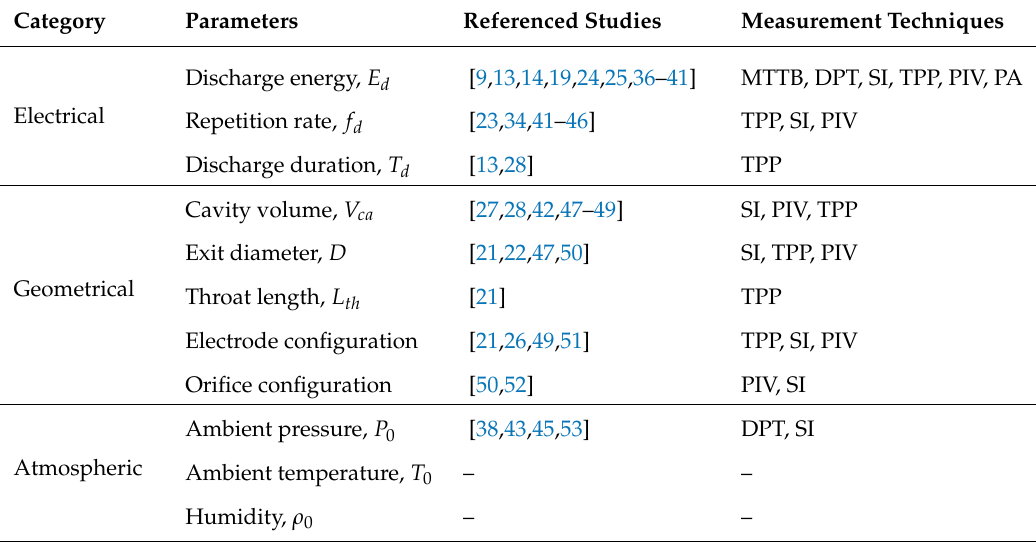
Table 1. Classification of previous studies based on the investigated jet formation parameters and the experimental techniques used. MTTB—miniature thrust test bed; DPT—dynamic pressure transducer; SI—schlieren imaging; TPP—total pressure probe; PIV—particle imaging velocimetry; PA—pendulum